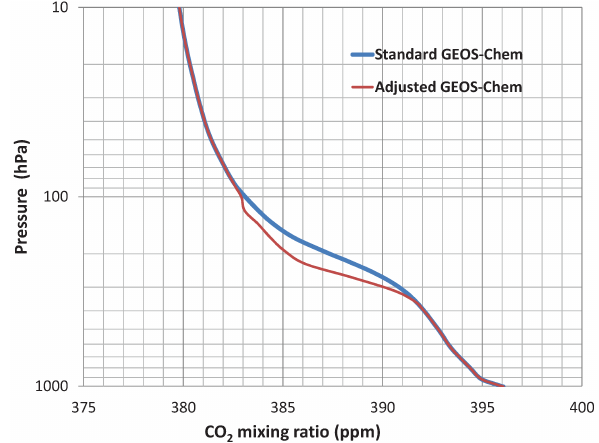
Figure 6. The mean profile of CO 2 in the Arctic before (in blue) and after (in red) the adjustment in CO 2 in the UTLS based on the HIPPO-3 CO 2 /O 3